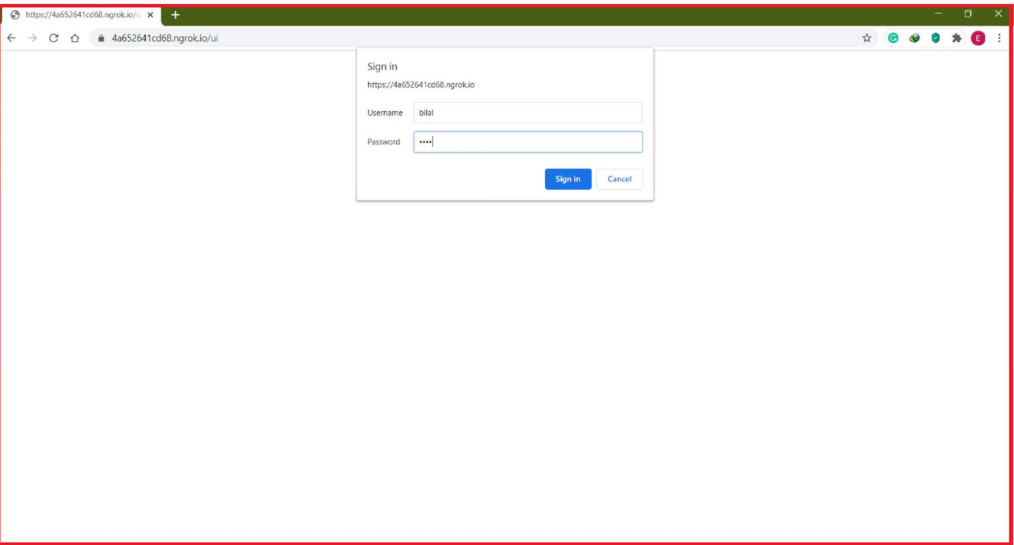
Figure 12. Web site to enter username and password in the